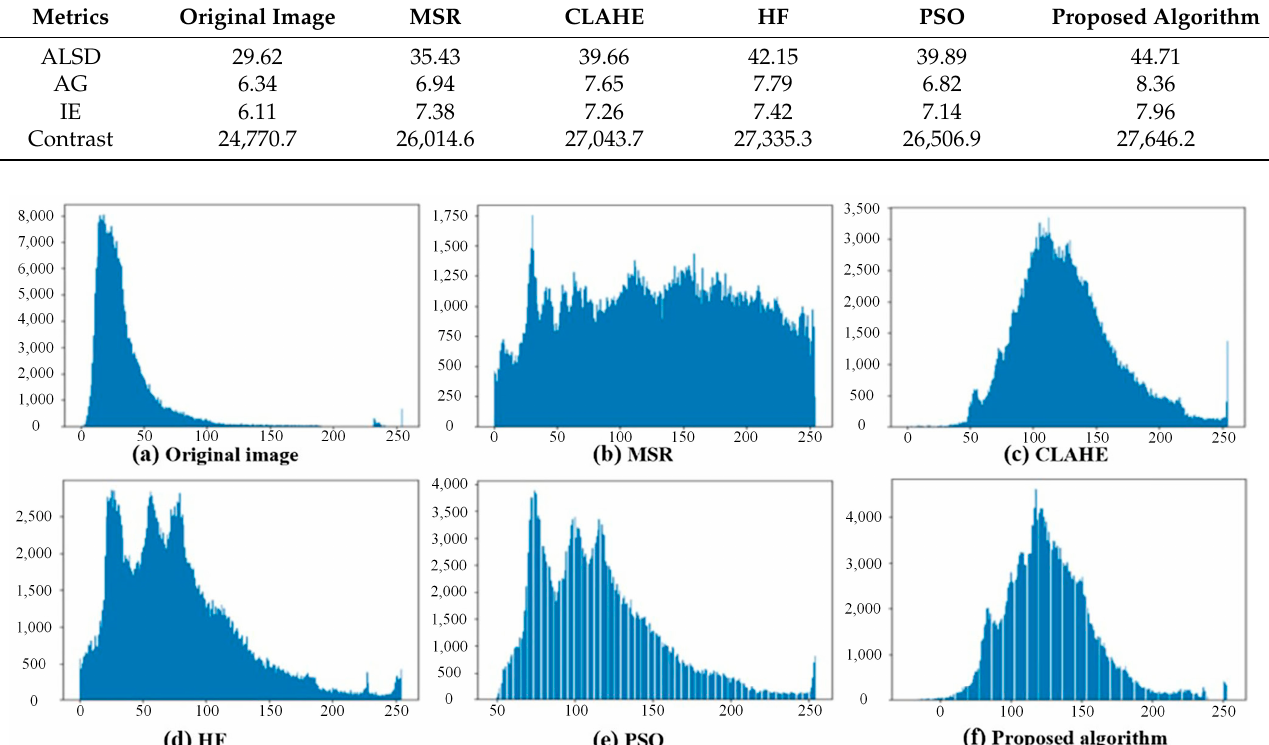
Figure 12. Enhancement histogram of mine image.